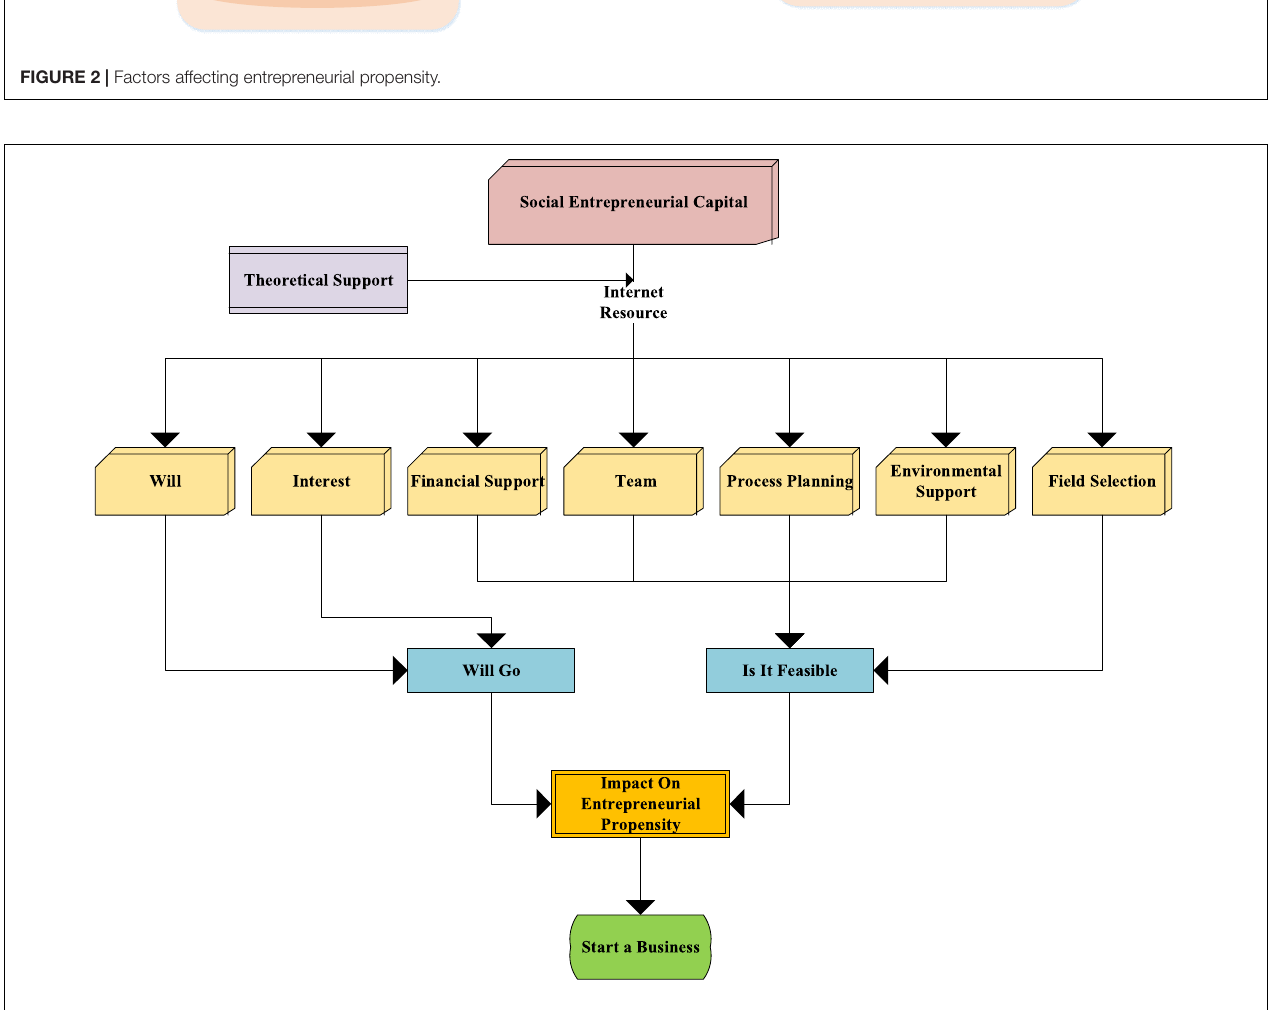
FIGURE 3 | The influence process of entrepreneurial